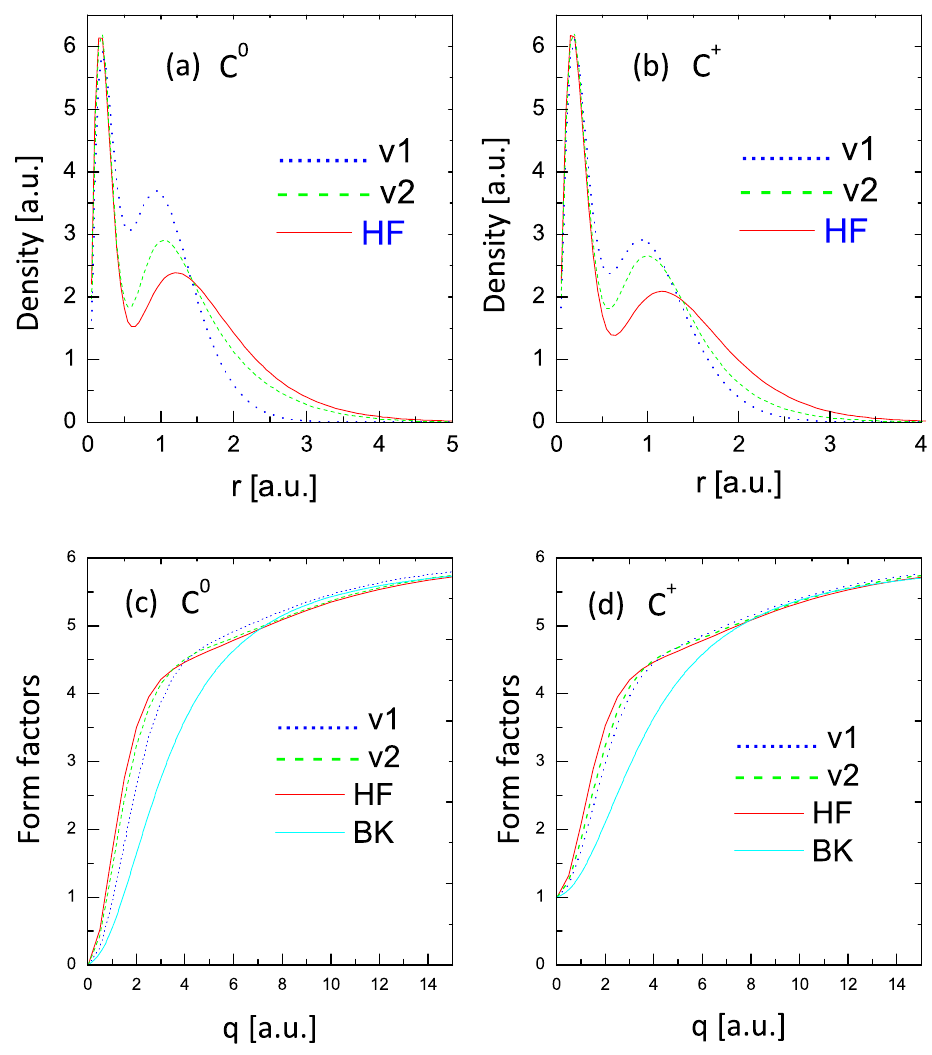
Figure 5. Radial densities (upper panels) and form factors (lower panels) for C 0 and C + . Dotted lines: one variational parameter; dashed lines: two variational parameters; solid red lines: HF values. The lower (BK) lines in panels ( c , d ) are the form factors calculated with the statistical model of Ref. [34].